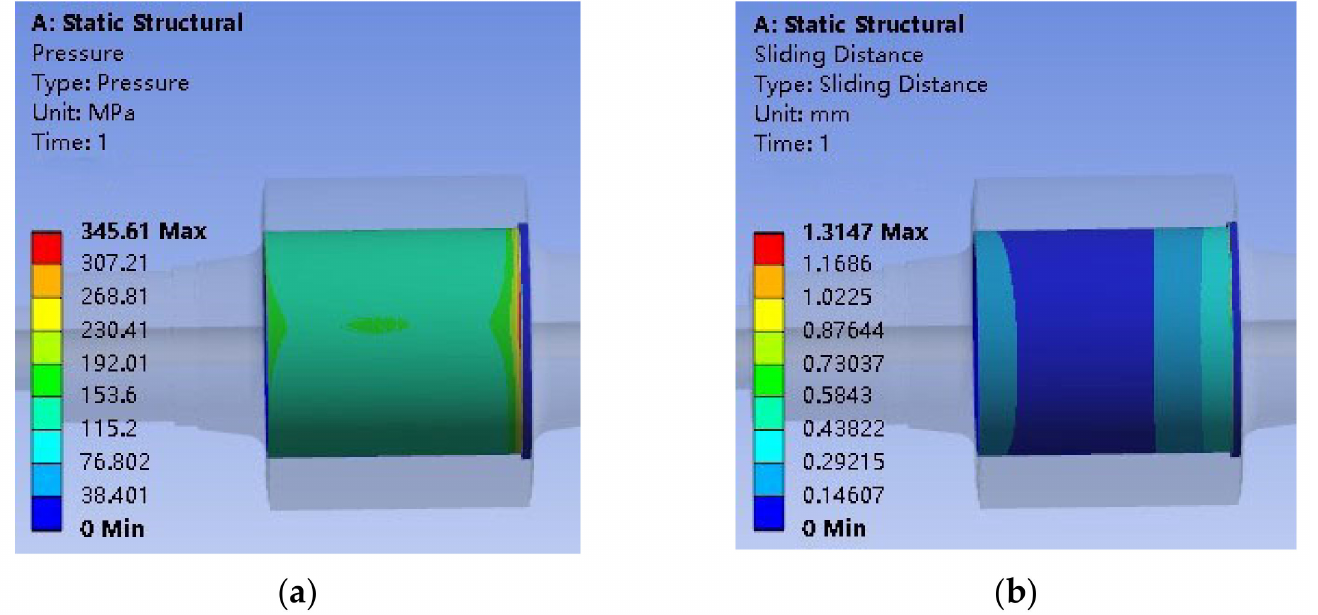
Figure 8. Interference contact nephograms: ( a ) contact stress nephogram; ( b ) sliding distance nephogram.